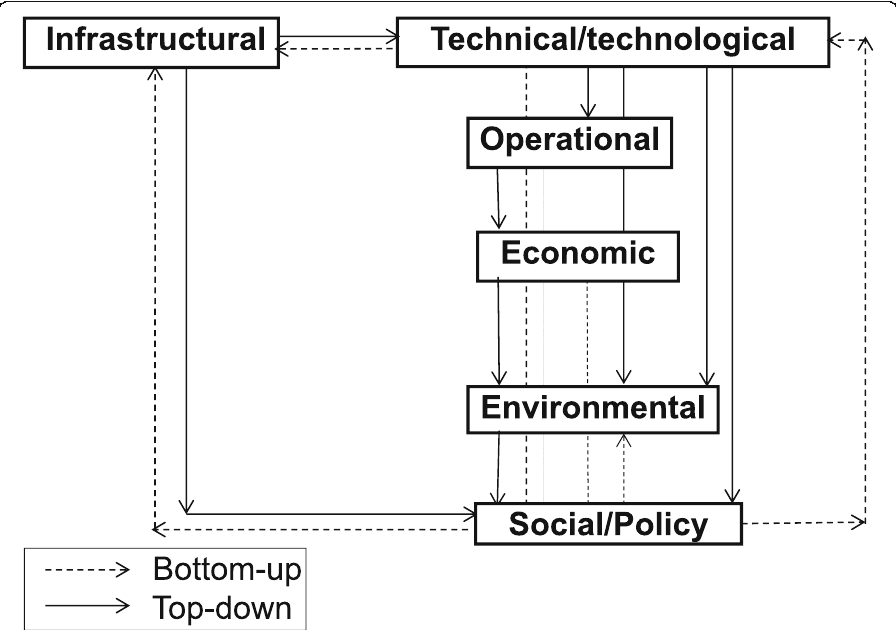
Fig. 4 Scheme of possible classification, potential interrelation and interaction of performances of the maritime part of an intercontinental supply chain (Jani ć